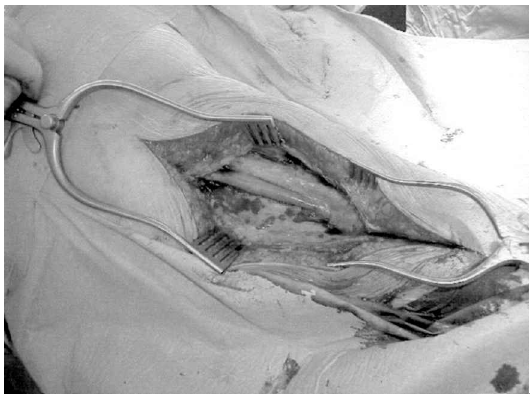
Fig. 2. The seroma sac cut open to reveal the sciatic